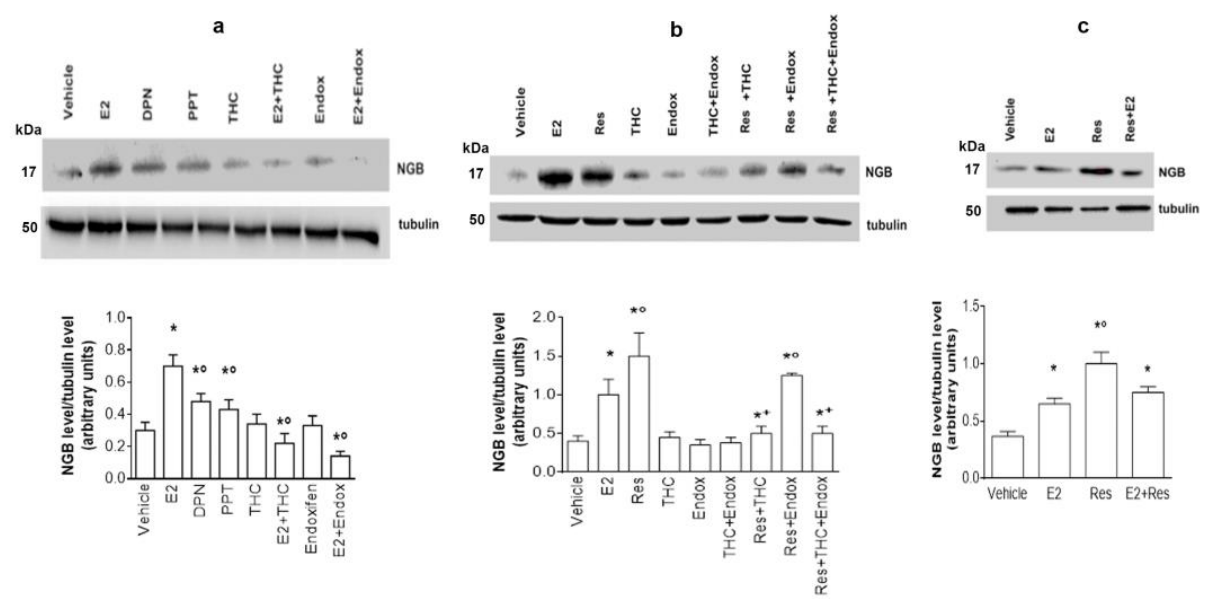
Figure 2. Action mechanisms of Res in SH-SY5Y cells. ( a ) Western blot analysis of NGB levels in SH-SY5Y cells pretreated with (R,R)-THC (10 − 6 M) and Endoxifen (Endox, 10 ~6 M) inhibitors, 1 h before administration, for 24 h, of either vehicle (DMSO 1:1000, v : v ), E2 (10 − 9 M), DPN (10 − 9 M), PPT (10 − 9 M), and the co-treatment with E2 + (R,R)-THC and E2 + Endox at the same concentrations. Tubulin protein was used to normalize blot loading. The upper panel shows a Western blot type, and the lower panel shows the densitometric analysis of at least three different experiments. Data are reported as mean ± SD. p < 0.05 was calculated with Student’s t -test with respect to the vehicle (*) or with respect to E2 ( ◦ ). ( b ) Western blot analysis of NGB levels in SH-SY5Y cells pretreated as described in panel a. Tubulin protein was used to normalize blot loading. The upper panel shows a Western blot type, and the lower panel shows the densitometric analysis of at least three different experiments. Data are reported as mean ± SD. p < 0.01 was calculated with Student’s t -test with respect to vehicle (*), E2 ( ◦ ), and Res (+). ( c ) Western blot analysis of NGB levels in SH-SY5Y cells treated for 24 h with vehicle (DMSO 1:1000, v : v ) or with E2 (10 ~9 M) or with Res (10 − 7 M) or co-treated with E2 + Res at the same concentrations. Tubulin protein is used to normalize blot loading. The upper panel shows a Western blot type, and the lower panel shows the densitometric analysis of at least three different experiments. p < 0.01 was calculated with Student’s t -test with respect to vehicle ( ◦ ) or with respect to E2 (*).